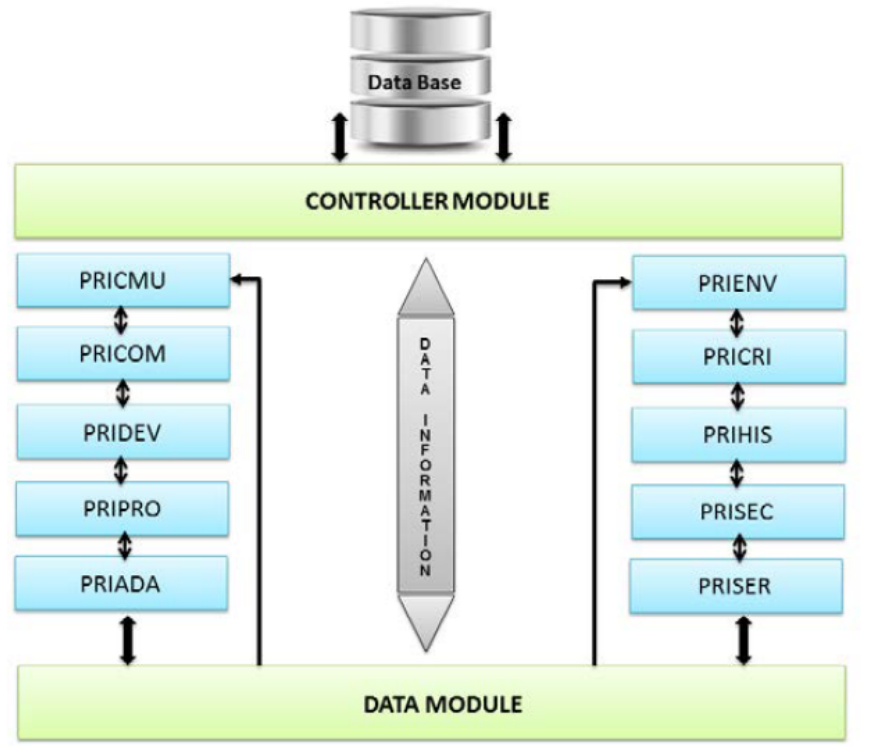
Figure 3. UbiPri Middleware